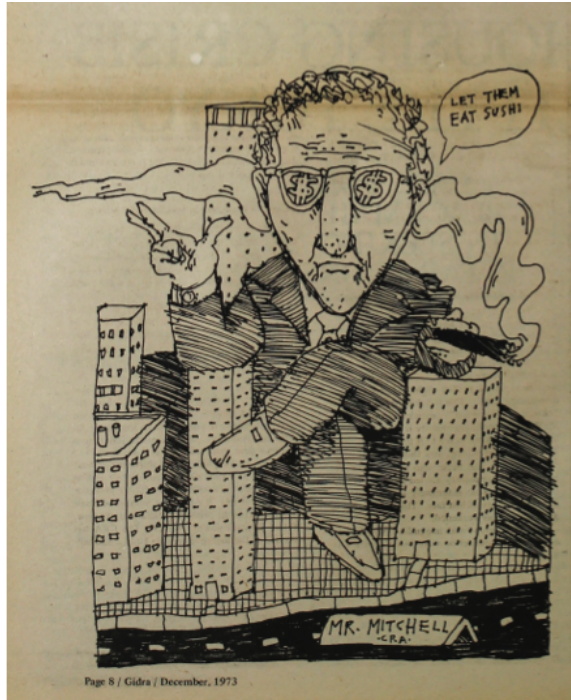
FIGURE 2. ILLUSTRATION FROM GIDRA DEPICTING CORPORATE DEVELOPMENT